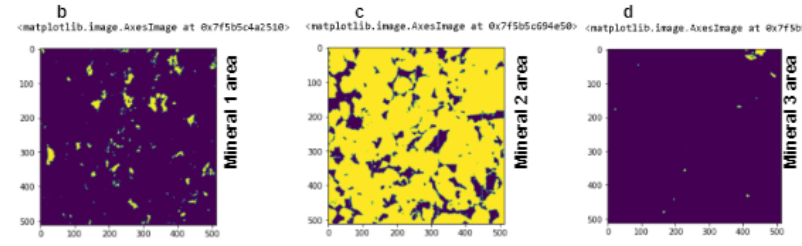
Figure 5. Individual particles of segmented images based on the pixel value on particular slices. ( a ) Represents pore area. ( b ) Represents mineral 1 area. ( c ) Represents mineral 2 area. ( d ) Represents mineral 3 area.